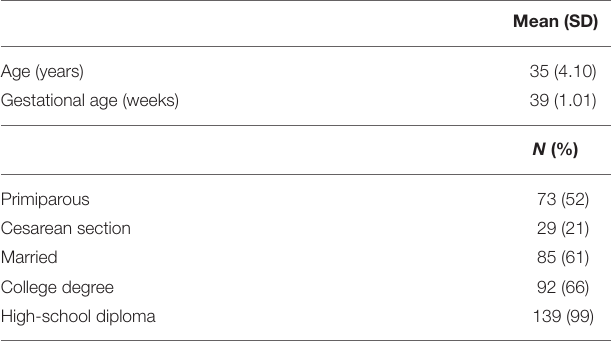
TABLE 2 | Basic characteristics of enrolled